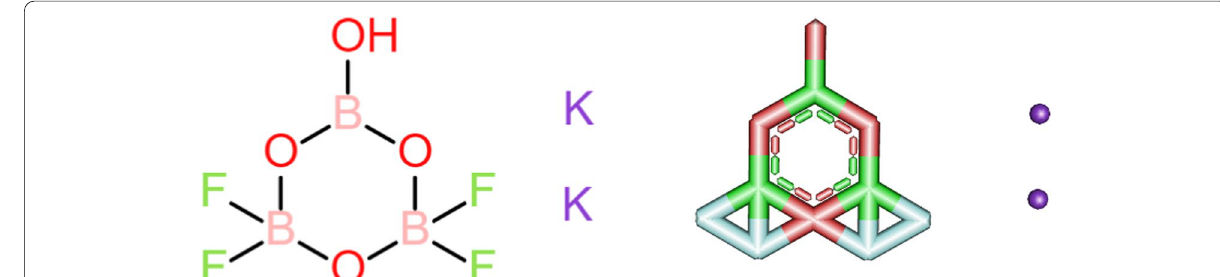
Fig. 1 Visualization of two- and three-dimensional structure of halogenated